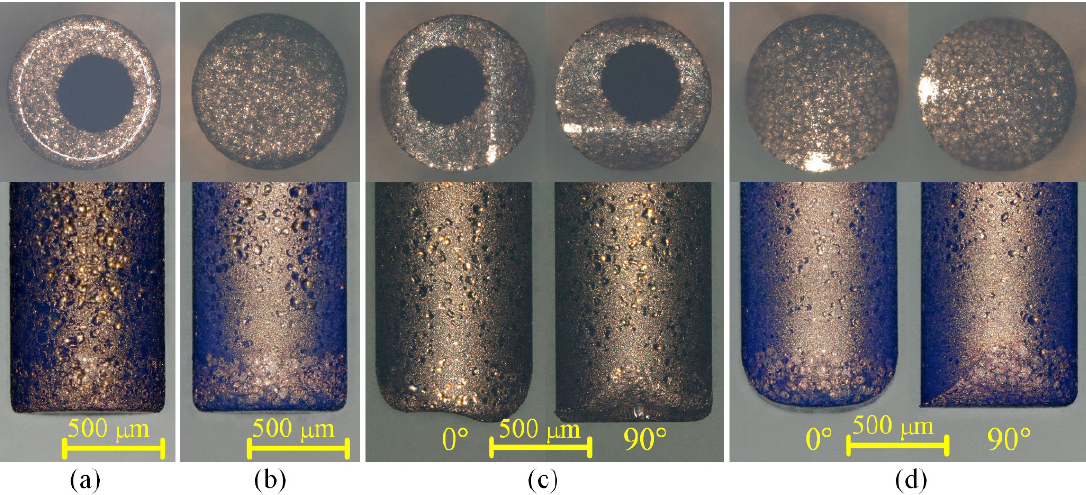
Figure 19. Optical images of the four electrodes in Exp. 2: ( a ) hollow electrode-rotating mode; ( b ) cylindrical electrode- rotating mode; ( c ) hollow electrode-nonrotating mode; ( d ) cylindrical electrode-nonrotating mode.